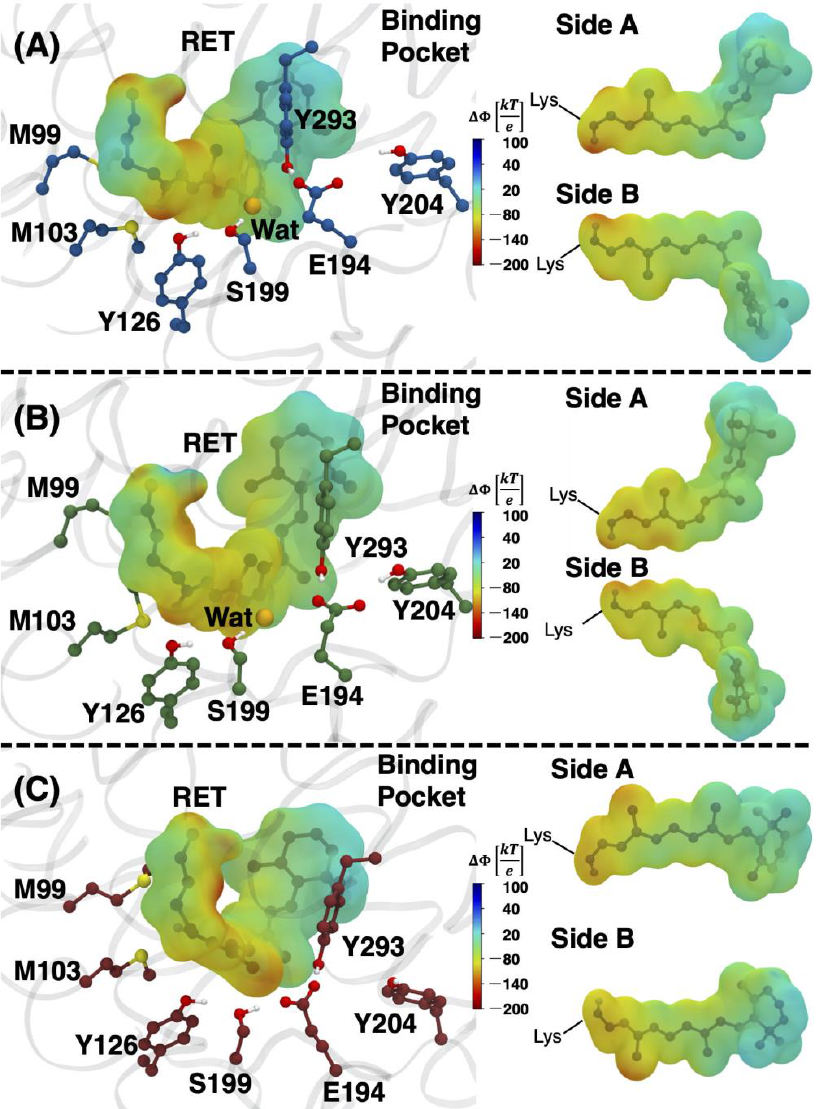
Figure 5. Electrostatic potentials generated for the ( A ) 9- cis , ( B ) 11- cis and ( C ) all- trans models determined using the APBS program and visualized with VMD [32,33]. The electrostatic interactions between the chromophore and the full protein environment were examined. Red indicates a negative electrostatic interaction from the environment, and blue indicates a positive electrostatic interaction. Additionally shown are side views of the retinal chromophore, excluding the lysine side chain, except for the Schiff base nitrogen.